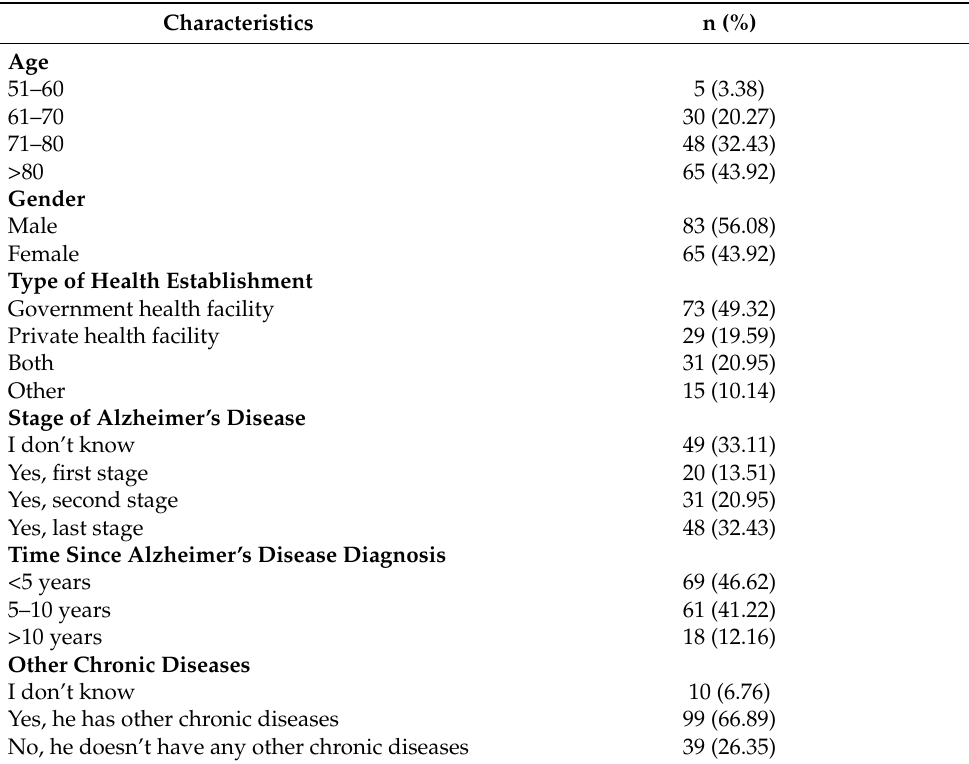
Table 2. Baseline Demographics and Characteristics of Alzheimer’s Patients Answered by the